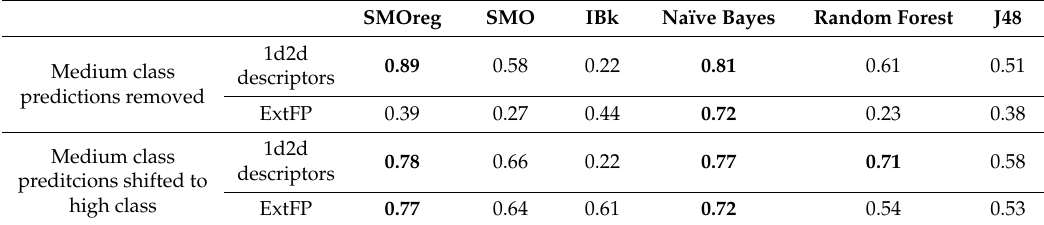
Table 5. Accuracies of predictions on external test set (T 1/2 human data on liver microsomes). Values above 0.7 are depicted in